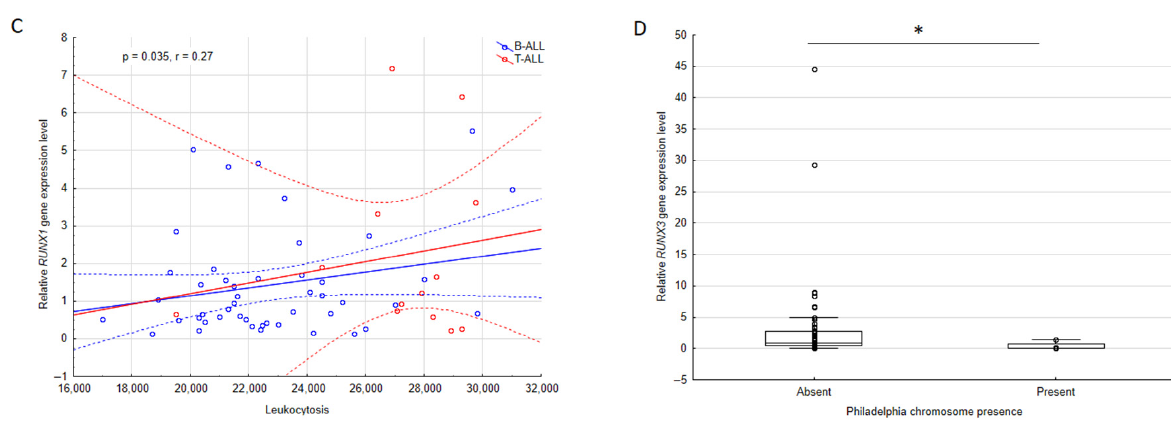
Figure 1. ( A )—box-whiskers plot for RUNX1 gene expression level comparison between ALL and control group, data presented as mean, standard error, and 95% confidence interval, raw data are presented as individual dots; ( B )—box-whiskers plot representing the difference in RUNX1 gene expression level between the high- and standard-risk patients, data presented as mean, standard error and 95% confidence interval, raw data are presented as individual dots; ( C )—scatterplot showing correlation between indicated RUNX1 gene expression and leukocytosis of ALL patients with subdivision for B-ALL (blue) and T-ALL (red), line represents a linear model fit whereas the dashed line indicates 95% confidence interval, each dot represents an individual; ( D )—box-whiskers plot representing the differences in RUNX3 gene expression and Philadelphia chromosome presence, data presented as median, interquartile and non-outlier range, raw data are presented as individual dots. * p < 0.05.